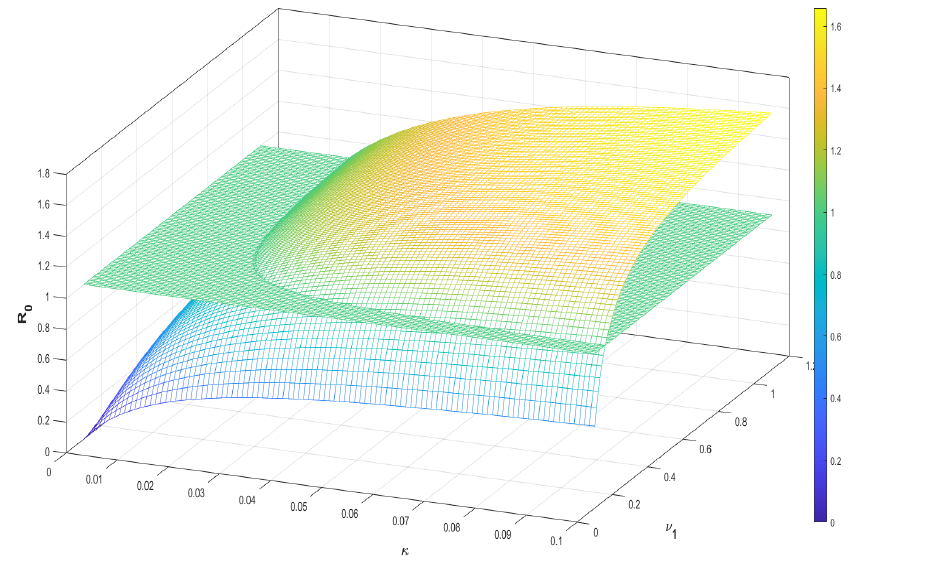
Figure 6. Shows a contour plot for the parameters κ and ν 1